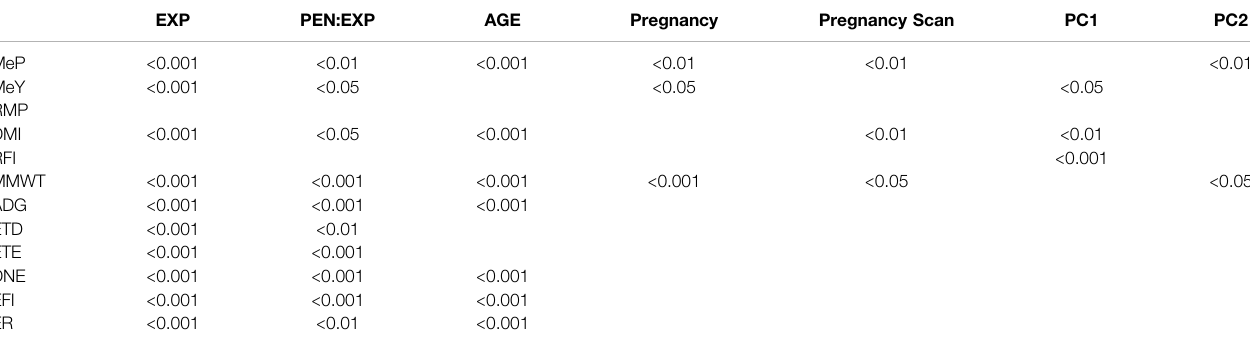
TABLE 5 | Signi fi cance of fi xed effects in univariate genomic best linear unbiased prediction models that combine phenotypes of Australian Maternal Composite ewes at post-weaning, hogget, and adult ages. Signi fi cance obtained with the Wald test [Pr (Chisq)]. Traits: Methane production (MeP), methane yield (MeY), residual methane production (RMP), dry matter intake (DMI), residual feed intake (RFI), metabolic mid-weight (MMWT), average daily gain (ADG), eating time per day (ETD), eating time per eatingevent(ETE),dailynumberofevents(DNE),eventfeedintake(EFI),andeatingrate(ER).Fixedeffects:Experiment(EXP),pennestedintoexperiment(PEN:EXP),daysof age (AGE), days of pregnancy at the end of the experiment (Pregnancy), number of lambs in pregnancy scan (Pregnancy Scan), fi rst (PC1) and second (PC2) principal components of the genomic relationship matrix.